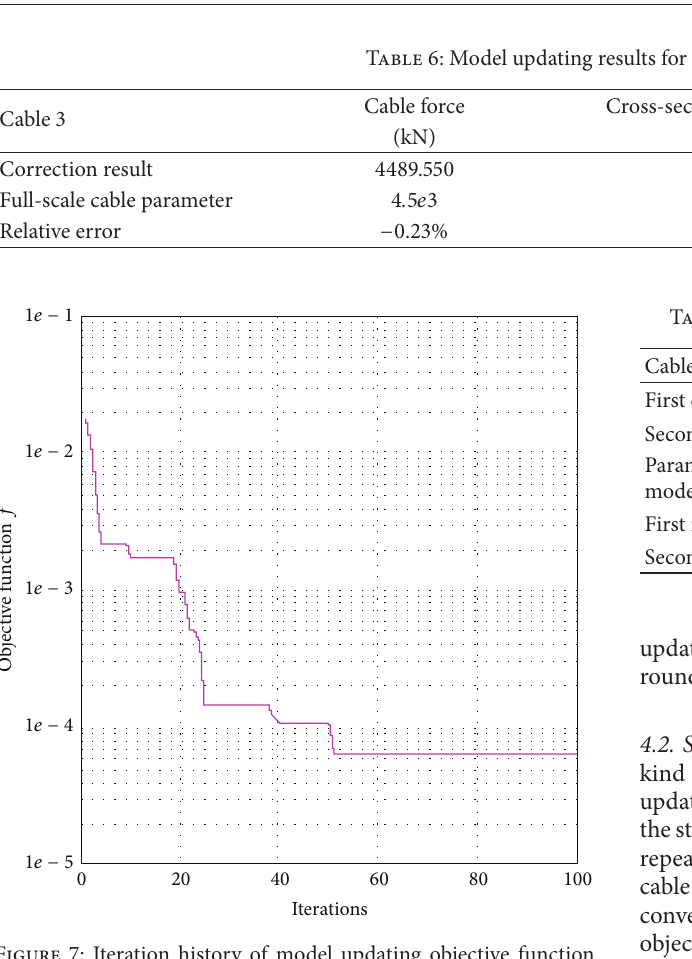
Figure 7: Iteration history of model updating objective function (cable B01).